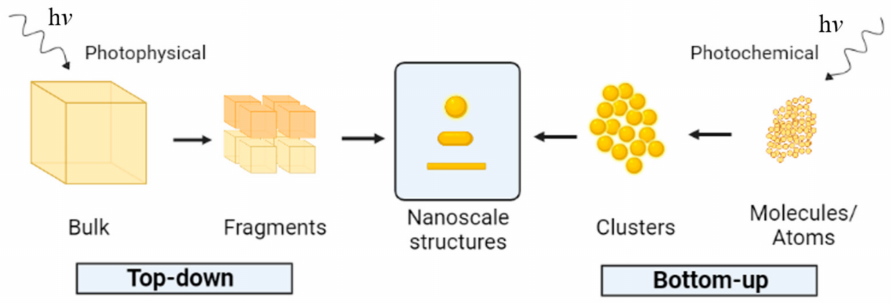
Figure 1. Illustration of the photochemical formation of